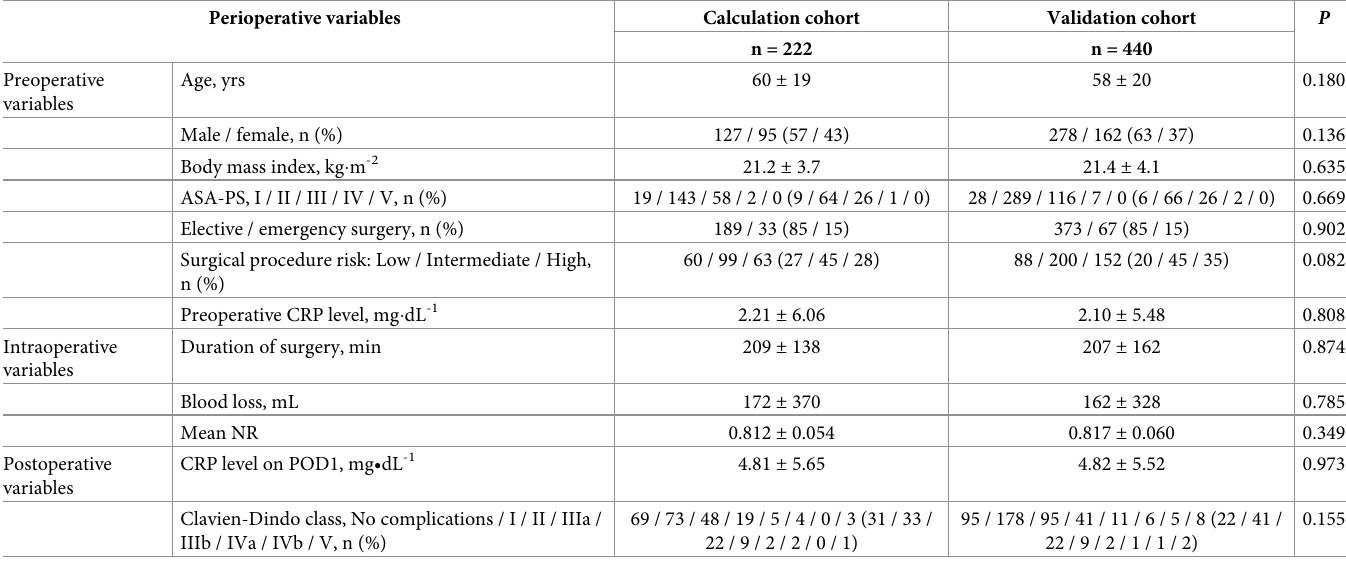
Table 1. Patient demographics and perioperative variables.